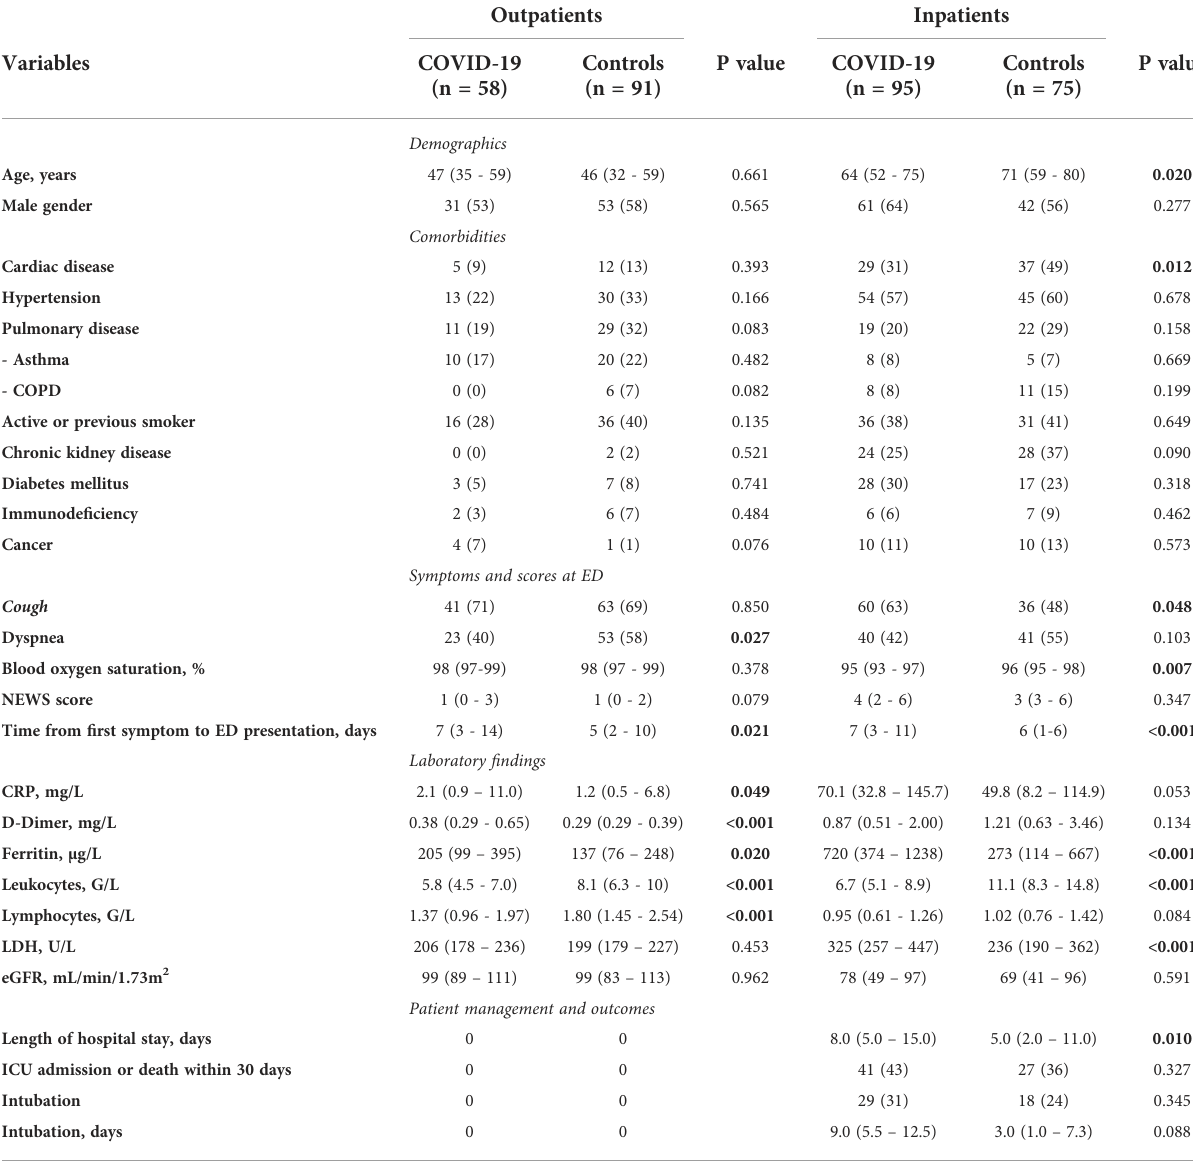
TABLE 1 Baseline